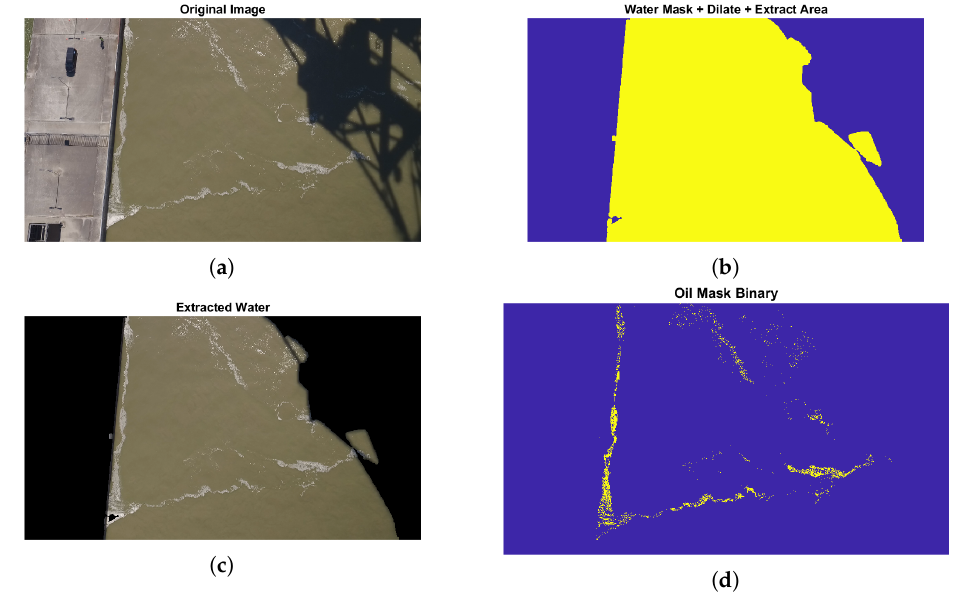
Figure 3. RGB Pipeline ( a ) Raw RGB image. ( b ) RGB image with the entire water/oil region extracted. ( c ) Raw RGB image with water/oil mask applied. ( d ) Oil extracted from ( c ).